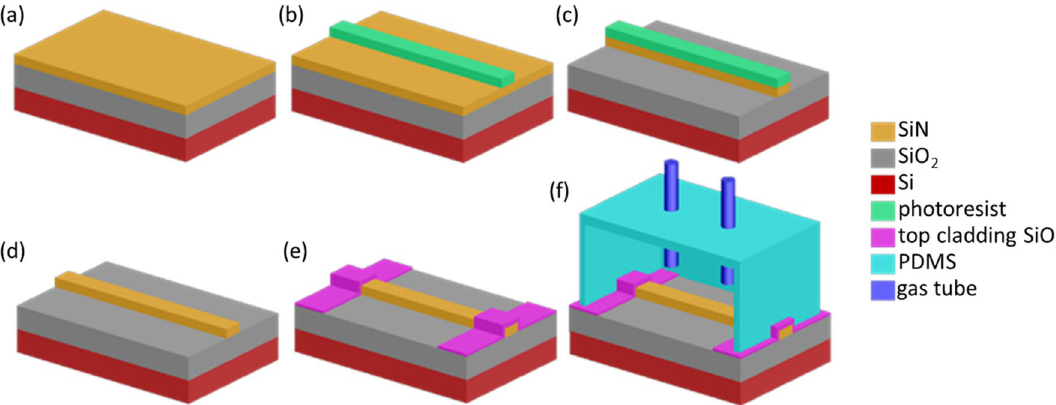
Figure 1. Fabrication process of the SiN waveguide and its assembly with a PDMS chamber. ( a ) Deposition of SiN thin film by LPCVD. ( b ) Creation of waveguide patterns by photolithography. ( c ) Transfer of the waveguide pattern to the SiN layer by RIE. ( d ) Removal of photoresist. ( e ) Deposition of the top SiO 2 cladding layer. ( f ) Bonding of the PDMS chamber to the waveguide